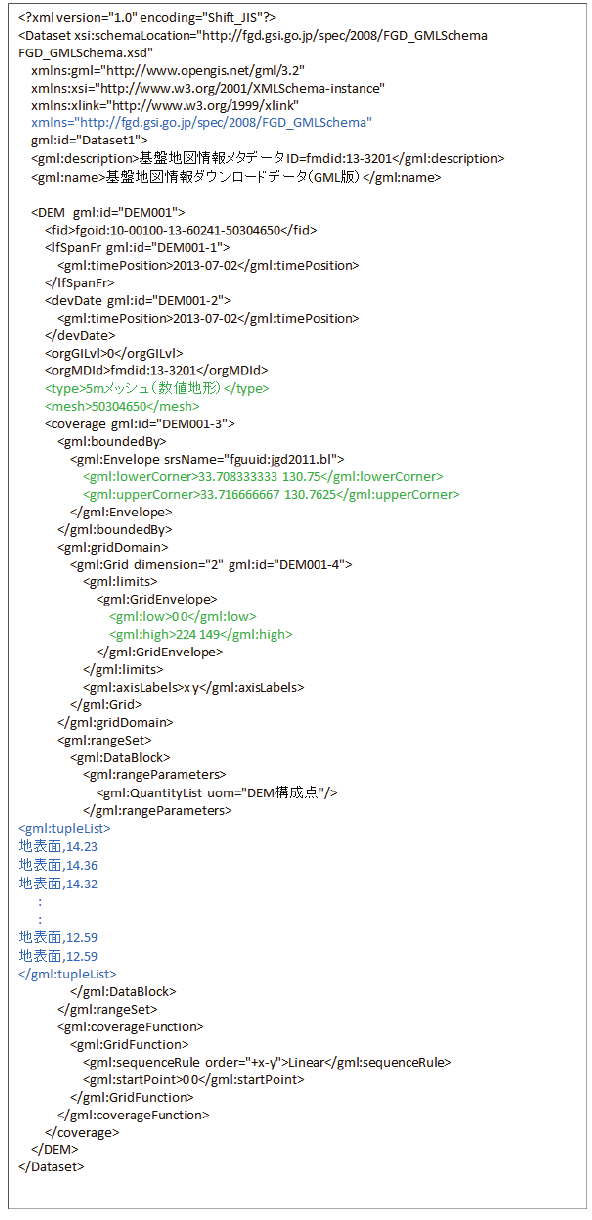
Figure 4. 5mDEM file format (GML)